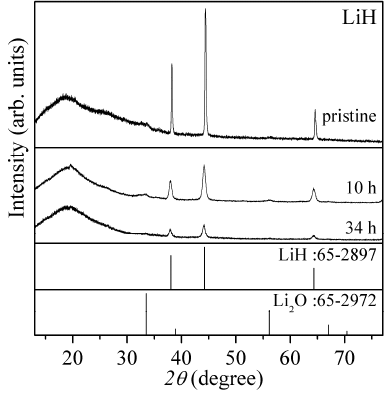
Figure 1. XRD (X-ray diffraction) patterns of the pristine and ball-milled LiH (10 h and 34 h). XRD patterns of LiH and Li 2 O in database are also shown as